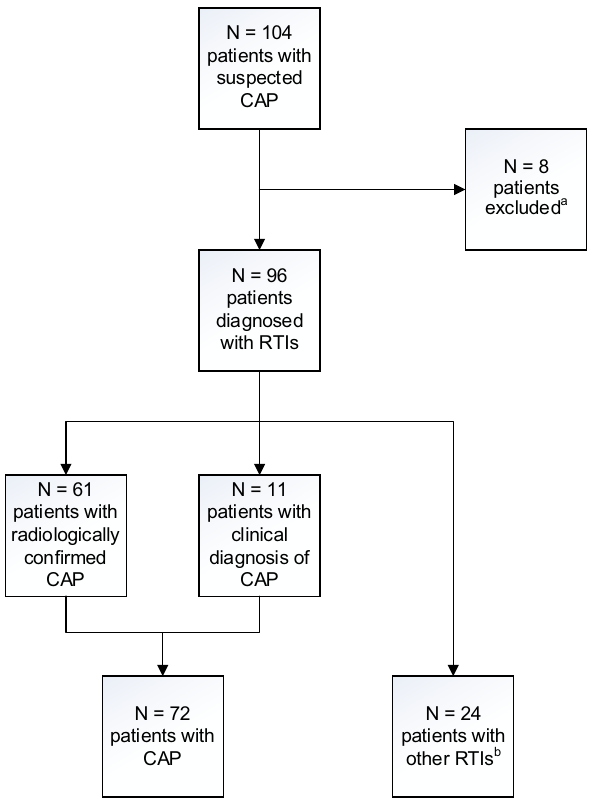
Figure 1. Study flowchart. CAP, community acquired pneumonia; RTI, respiratory tract infection; COPD, chronic obstructive pulmonary disease. a Eight patients were excluded due to other diagnoses: non-infectious exacerbation of COPD (n = 2); heart failure (n = 2); unspecified non-infectious dyspnea (n = 2); urinary tract infection (n = 1); aortic graft infection (n = 1). b Acute bronchitis (n = 10), acute infectious exacerbation of